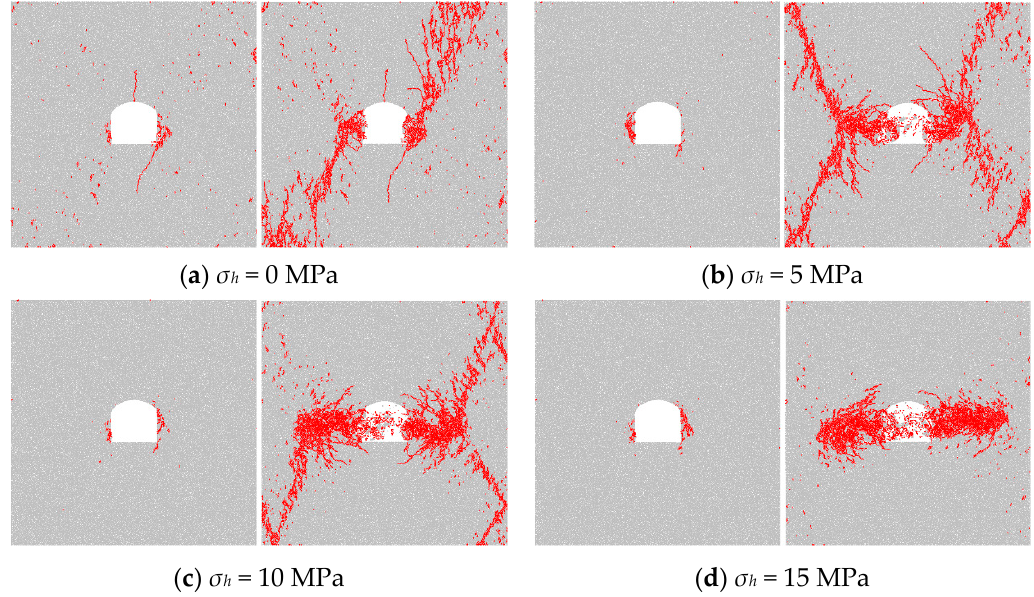
Figure 14. Failure patterns of numerical specimens containing an inverted U-shaped opening.